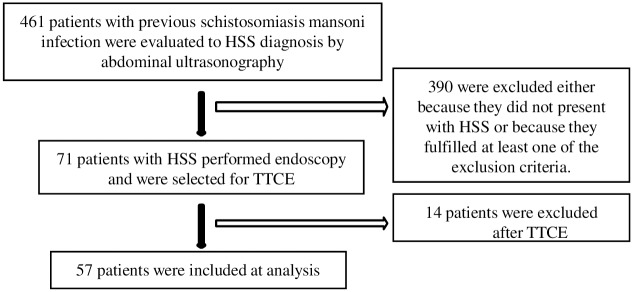
Flowchart of patient selection.